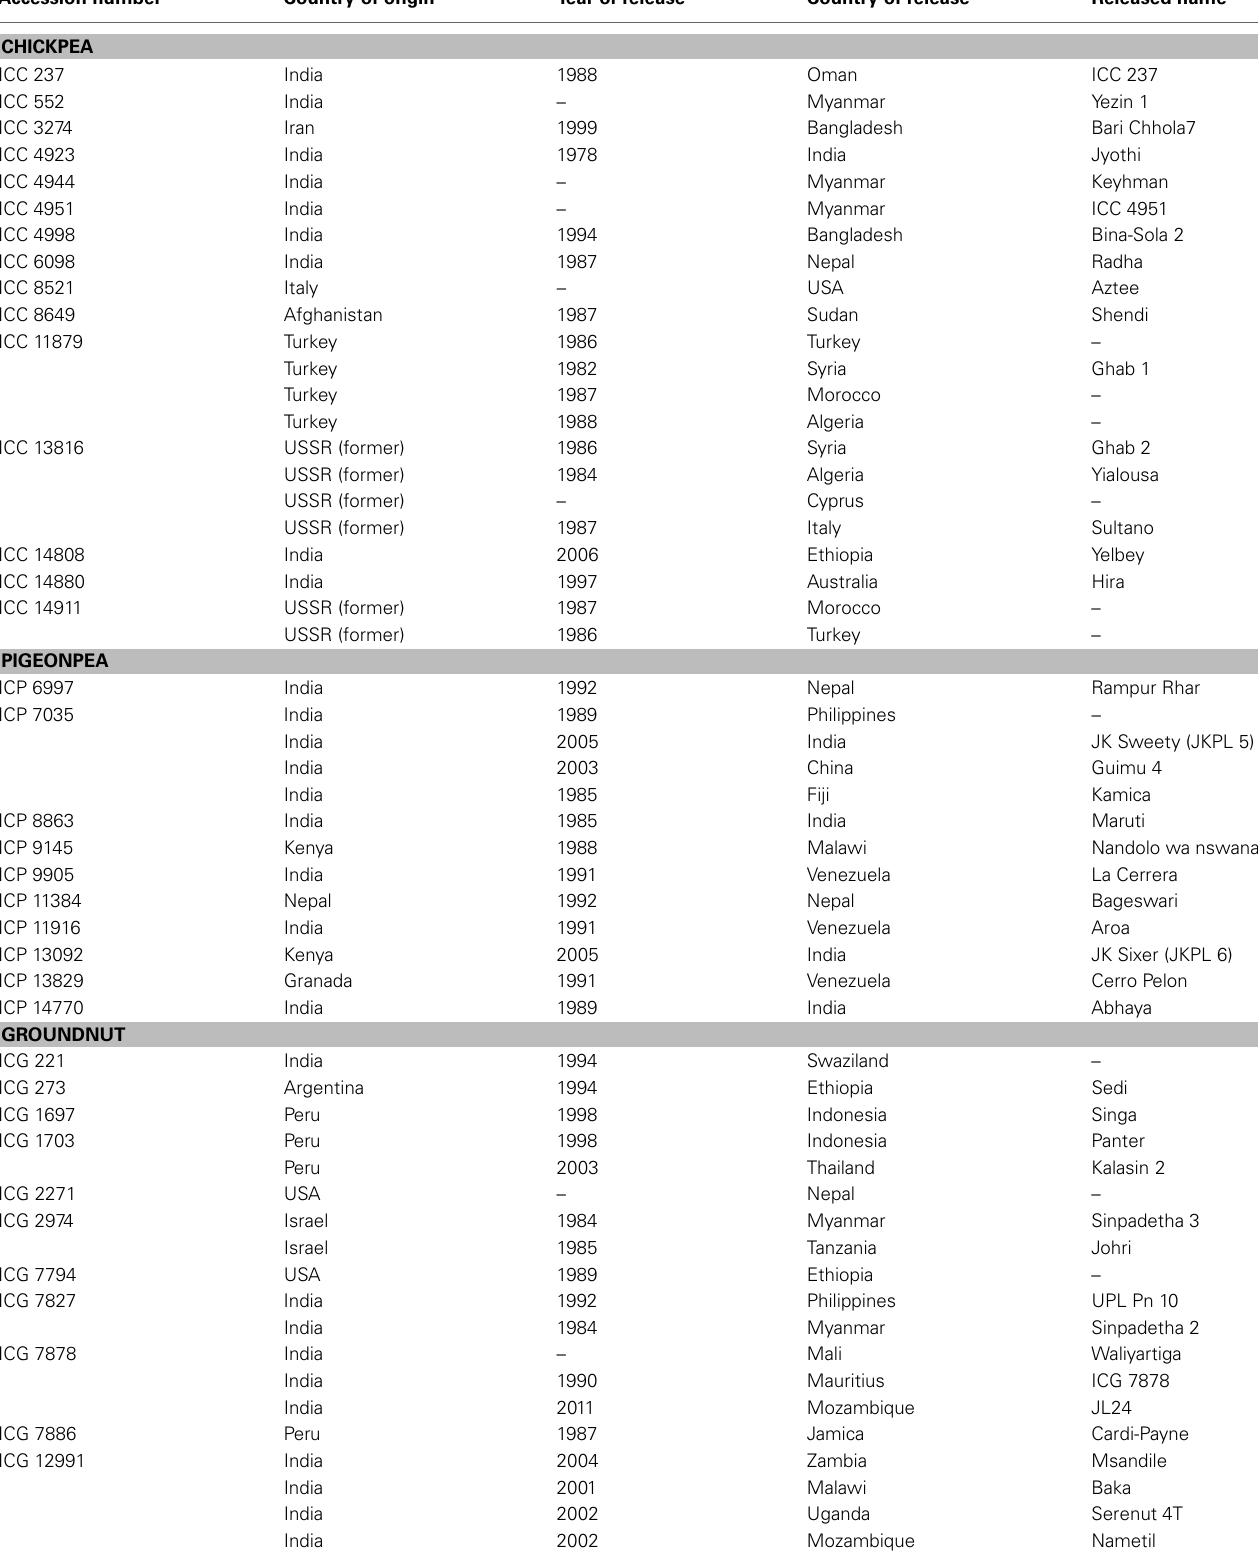
Table 1 | List of chickpea, pigeonpea and groundnut germplasm accessions directly released as varieties for